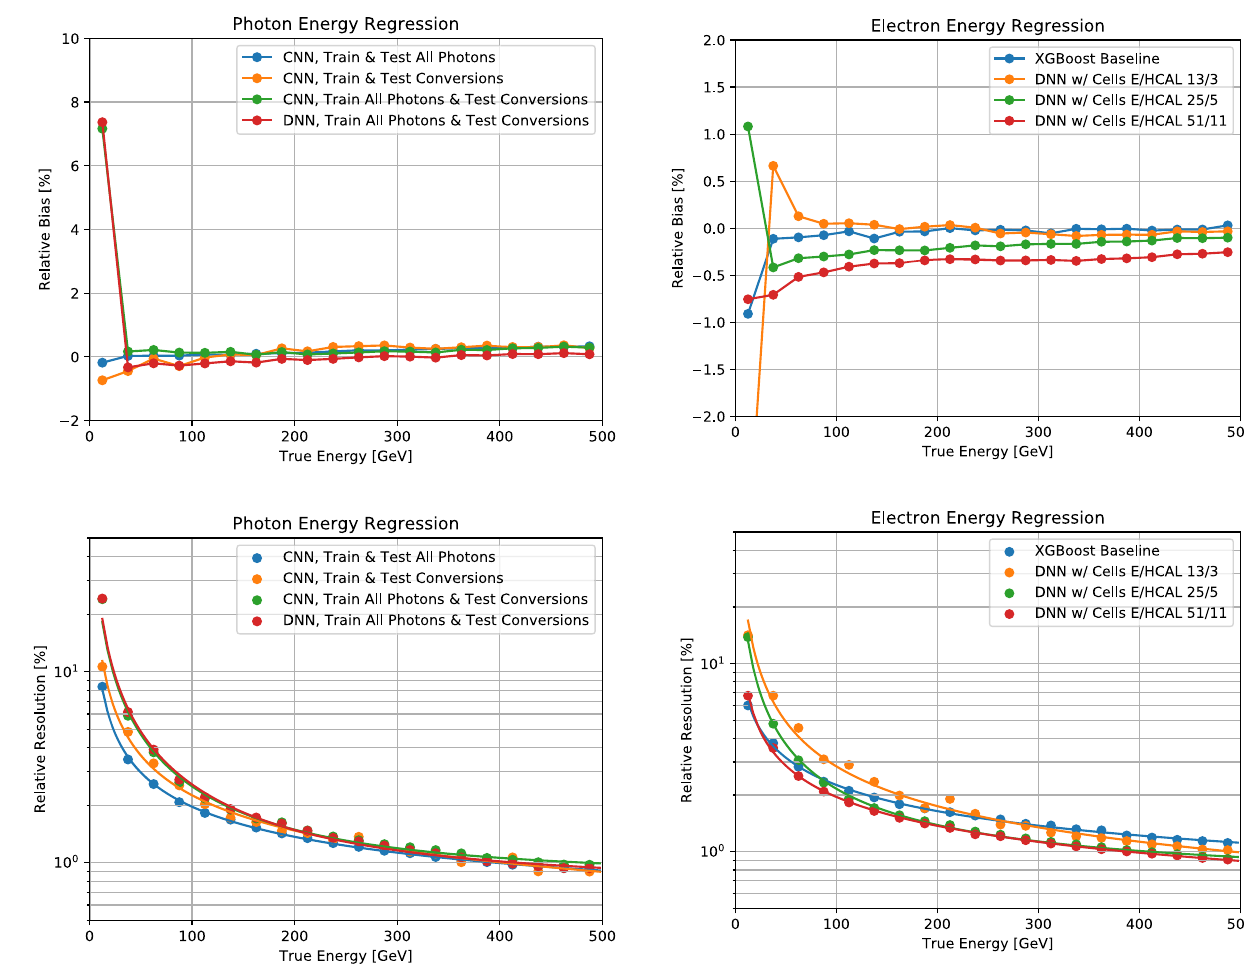
This is presumably due to wider showers at low energy. The Fig. 40, with the results for CNN being similar.